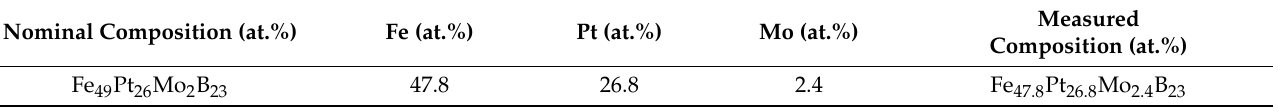
Table 1. The measured sample composition, as revealed from EDX analysis of the as-cast sample. Nominal Composition (at.%) Fe (at.%) Pt (at.%) Mo (at.%)